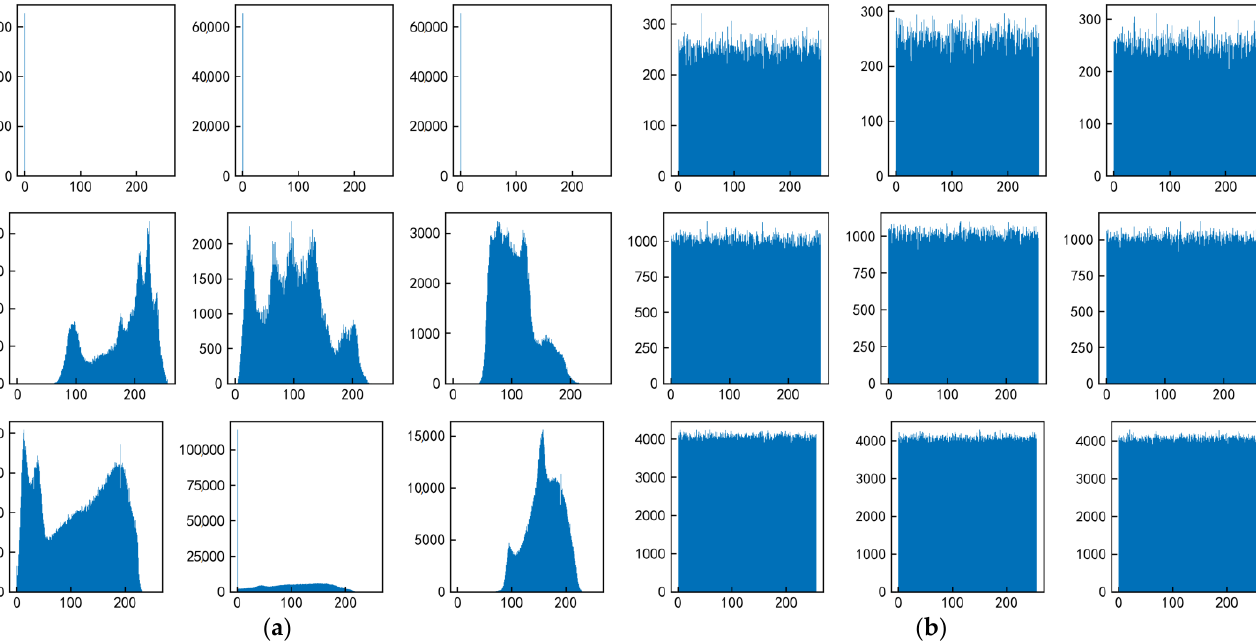
Figure 9. Pixel histogram of the encrypted image based on the encryption algorithm and key of the experimental image. ( a ) Histogram of plain image. ( b ) Histogram of cipher image.